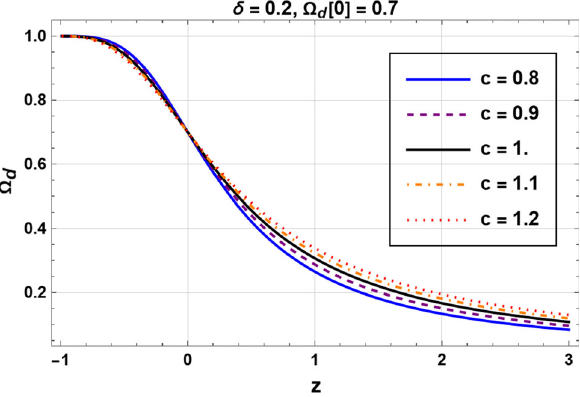
Fig. 1 NTHDE density parameter (cid:6) d with δ = 0 . 2 and c = 0 . 8 to 1 . 2 is plotted w.r.t. redshift z by considering (cid:6) d [ z = 0 ] ≈ 0 . 7 , M 2 p =